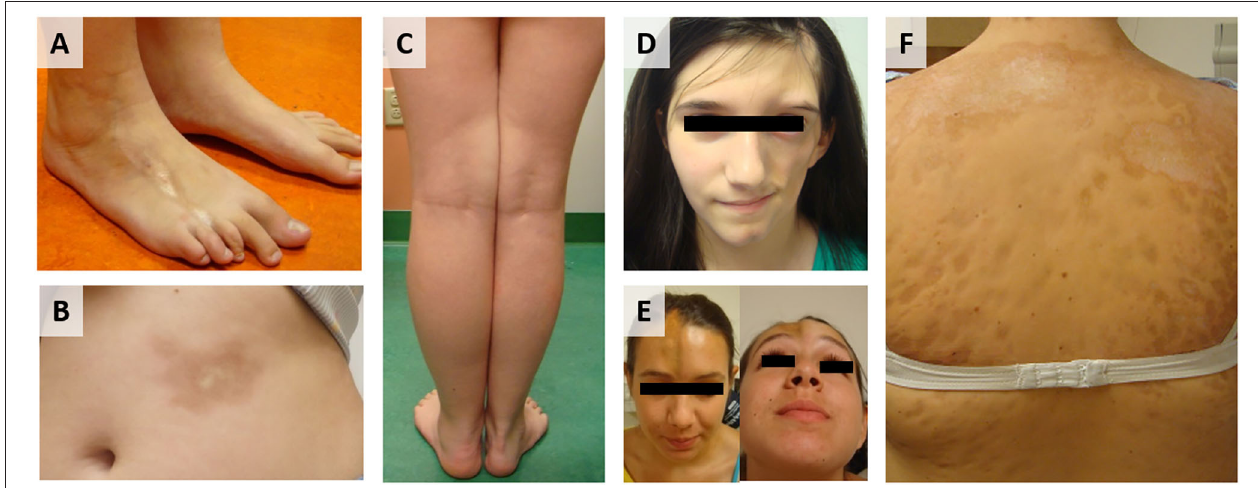
FIGURE 1 | Juvenile Localized scleroderma (LS) subtypes: (A) Linear leg lesion with atrophy of the third toe, (B) Circumscribed plaque morphea lesion trunk, (C) Linear limb lesion with subsequent atrophy and limb length discrepancy, (D) LS of the head leading to hemi facial atrophy (Parry Romberg Syndrome), (E) LS of the head with en coupe de sabre (ECDS) linear depression forehead/skull, (F) Generalized morphea with hyperpigmentation and central sclerosis of